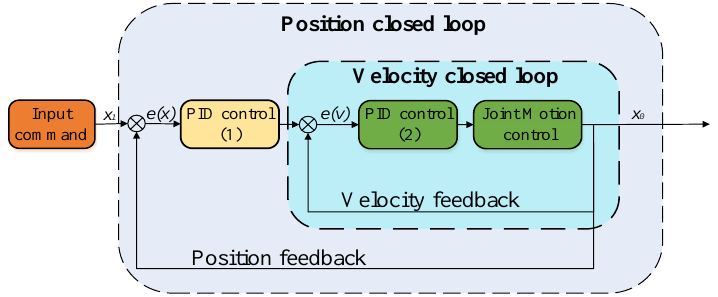
Figure 3. Cascade PID controller control block diagram.